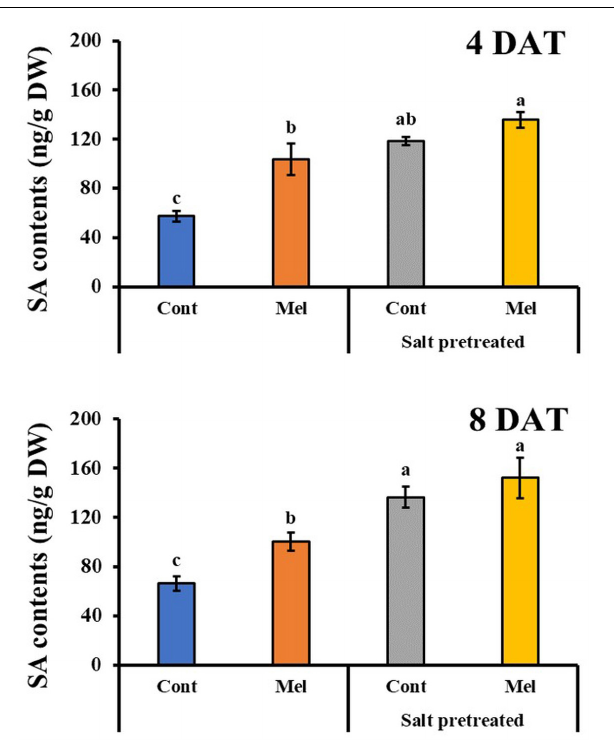
FIGURE 7 | Effect of melatonin with/without salt stress on ABA content in green mustard seedlings. The results were calculated from data for 4 (4DAT) and 8 (8DAT) days. Treatment: control + water, control + 1 µ M melatonin, 150 mM salt pre-treatment + water, 150 mM salt pre-treatment + 1 µ M melatonin. Values show the means ± SE ( n = 3). Letters represent significant differences at p < 0.05 in accordance with Duncan’s multiple range tests.